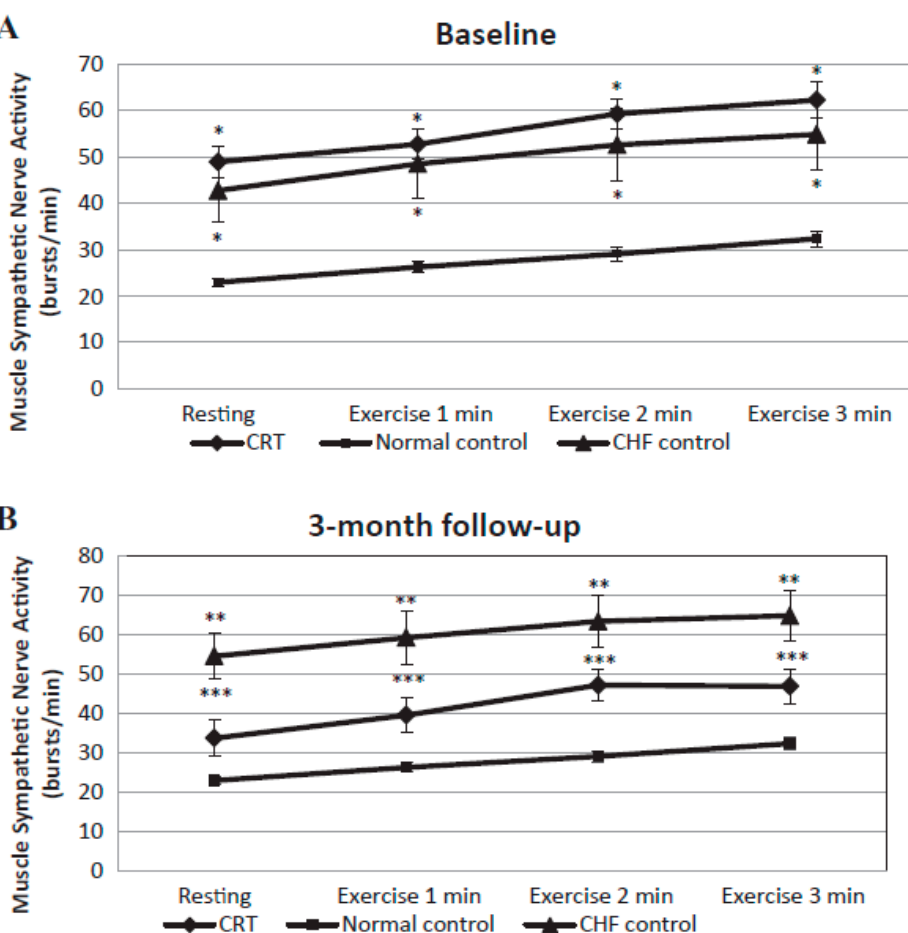
Figure 1. Muscle sympathetic nerve responses during moderate static exercise in congestive heart failure patients (CRT and control) compared with normal control subjects. ( A ) Moderate static handgrip exercise at baseline. ( B ) Moderate static handgrip exercise after a 3-month follow-up. * p < 0.001 vs. normal control. ** p = 0.005 vs. normal control. *** p = 0.003 vs. normal control. CHF = congestive heart failure, CRT = cardiac resynchronization therapy. The bars represent the standard deviation [53].